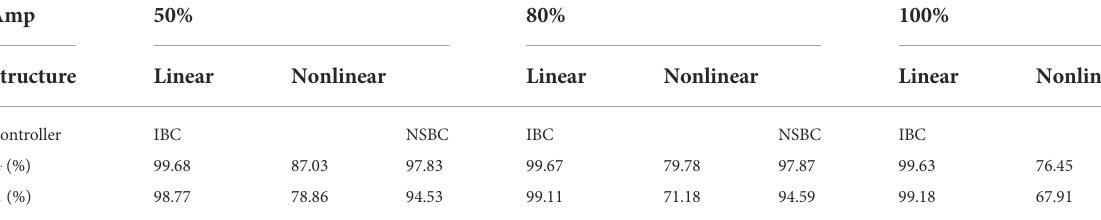
TABLE 2 Shake table control accuracies of IBC and NSBC in numerically disturbed experiments. Amp Structure